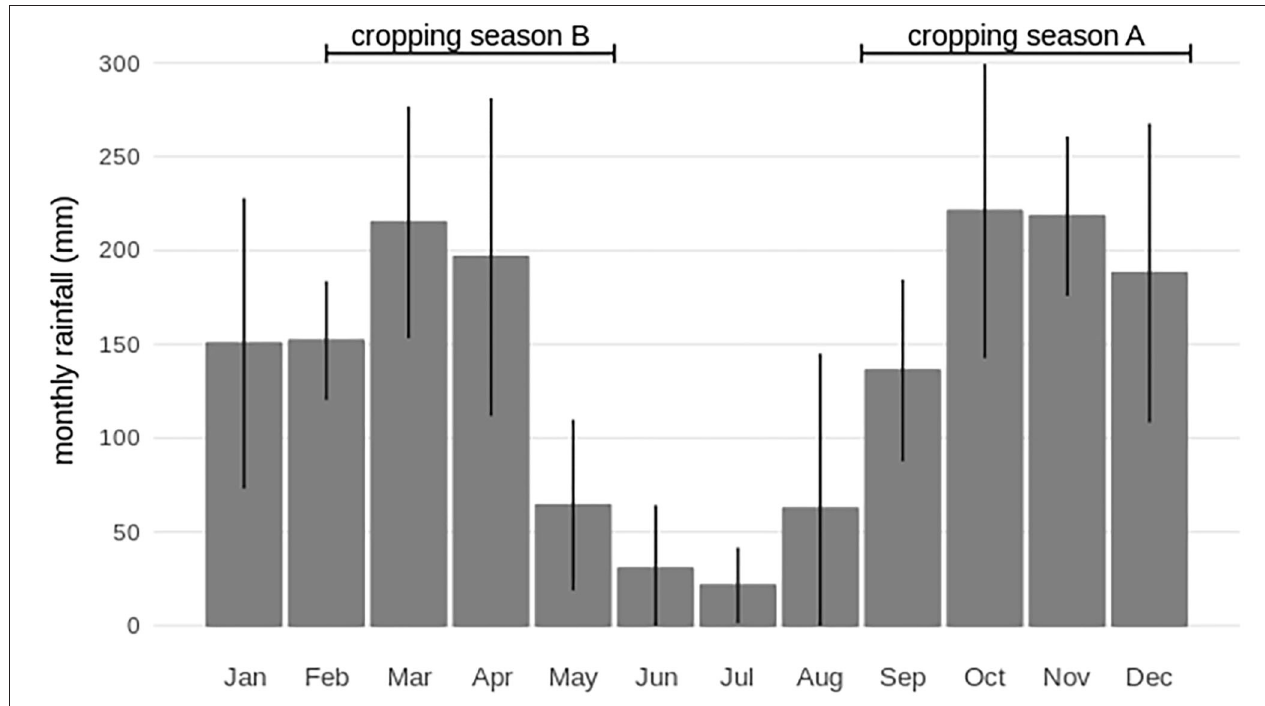
mid-February–March to May.